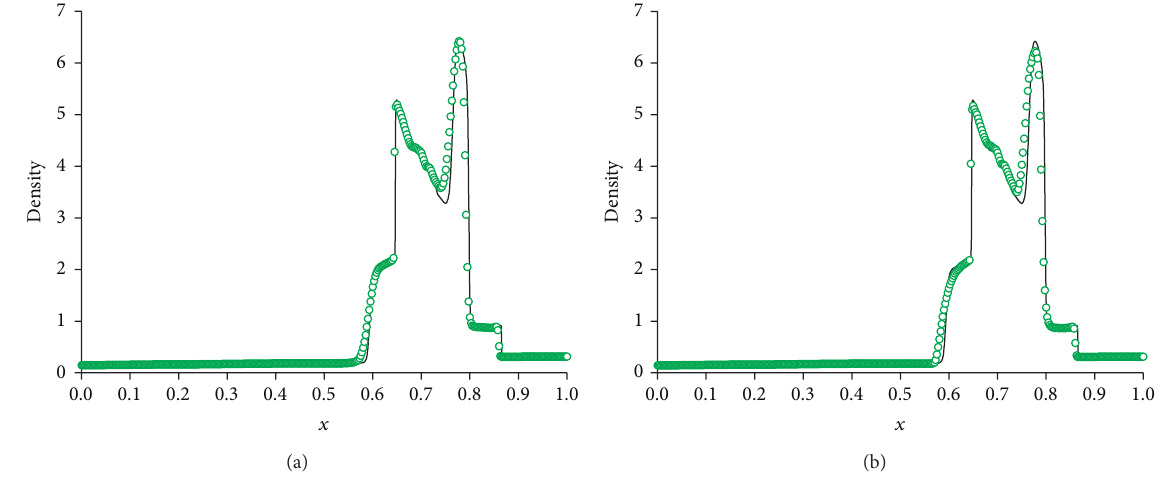
Figure 6: The numerical results of the two interacting blast waves problem at 𝑡 = 0.038 with CFL = 9.9 , 𝑁 = 400 ; (a) M-SL-FV WENO 5 scheme; (b) M-C-SL-FD WENO 5 scheme; solid line: exact solution; circle: computed